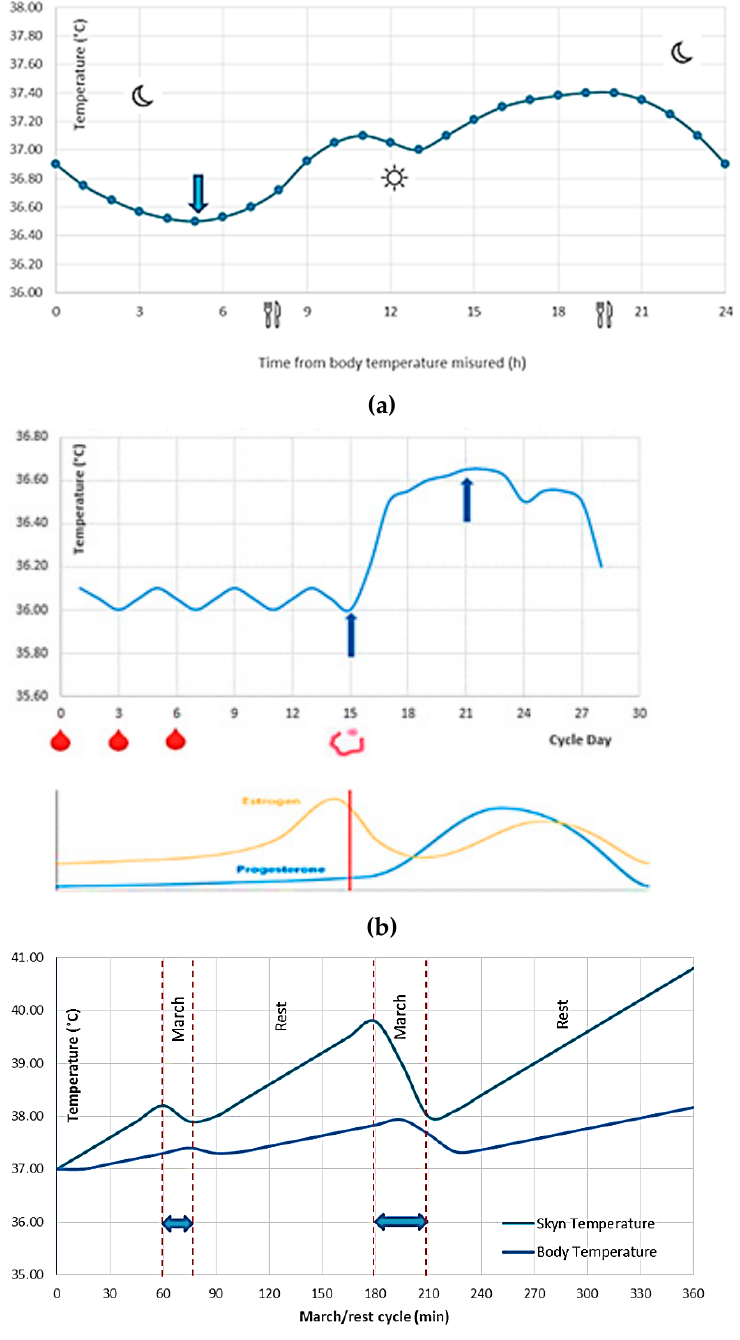
Figure 4. Typical body temperature trend: ( a ) circadian rhythm (the blue arrows represent respec- tively the minimum and the maximum peak during the day); ( b ) ovulatory cycle and hormonal concentration (the blue arrows represent the minimum and the maximum peak during the month, and the red drops represent the menstruation); ( c ) march/rest cycle (the metabolism due to muscle activity, in particular the blue arrows represent the march cycle and the remaining one the rest cycle) .